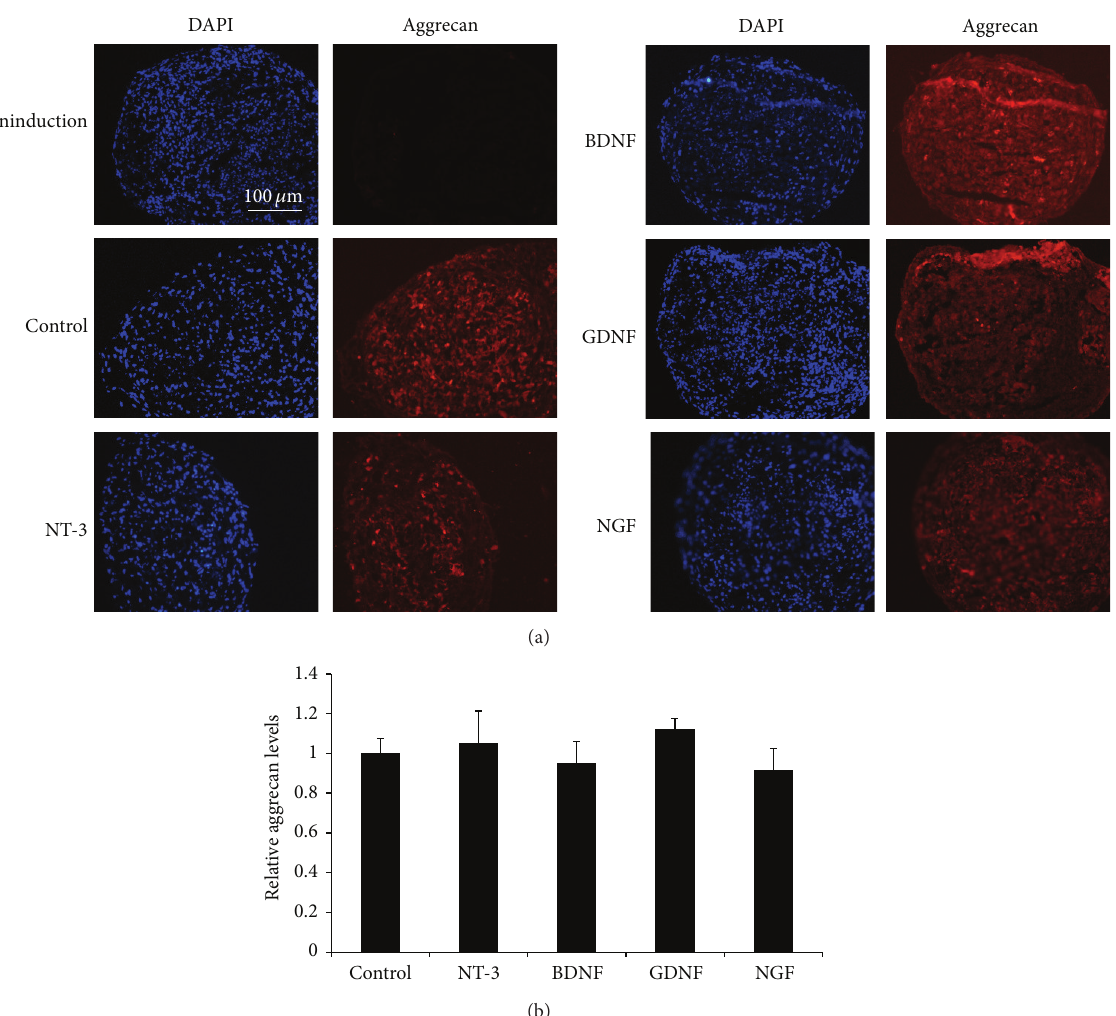
Figure 6: The effect of the overexpression of NTFs on the chondrogenic differentiation of MSCs. Transduced MSCs were cultured in chondrogenic induction medium for 21 days. (a) Cells were stained with anti-human aggrecan antibody and pictured in representative areas. Scale bar = 100 𝜇 m. (b) Relative aggrecan levels ( 𝑛 = 6